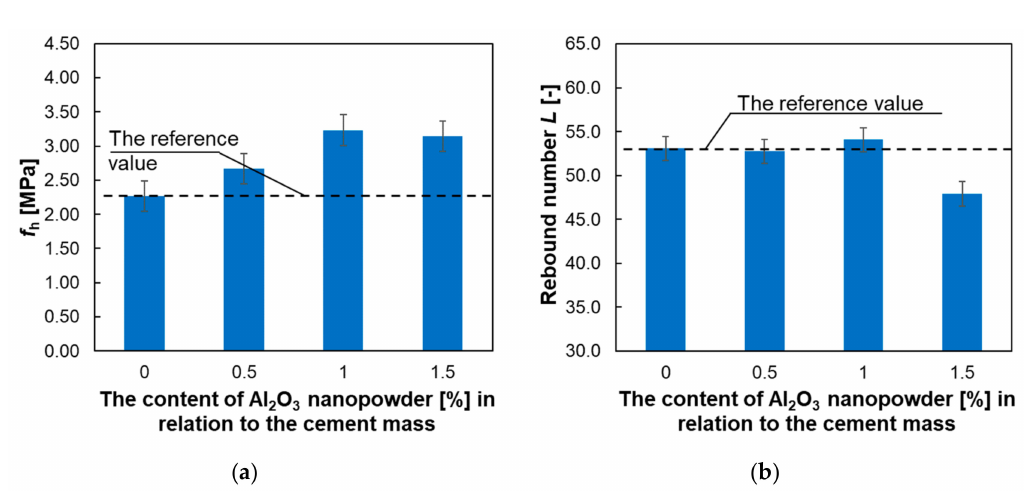
Figure 10. Test results of the cement mortars: ( a ) subsurface tensile strength f h ; ( b ) subsurface hardness defined by the rebound number L obtained using the sclerometric